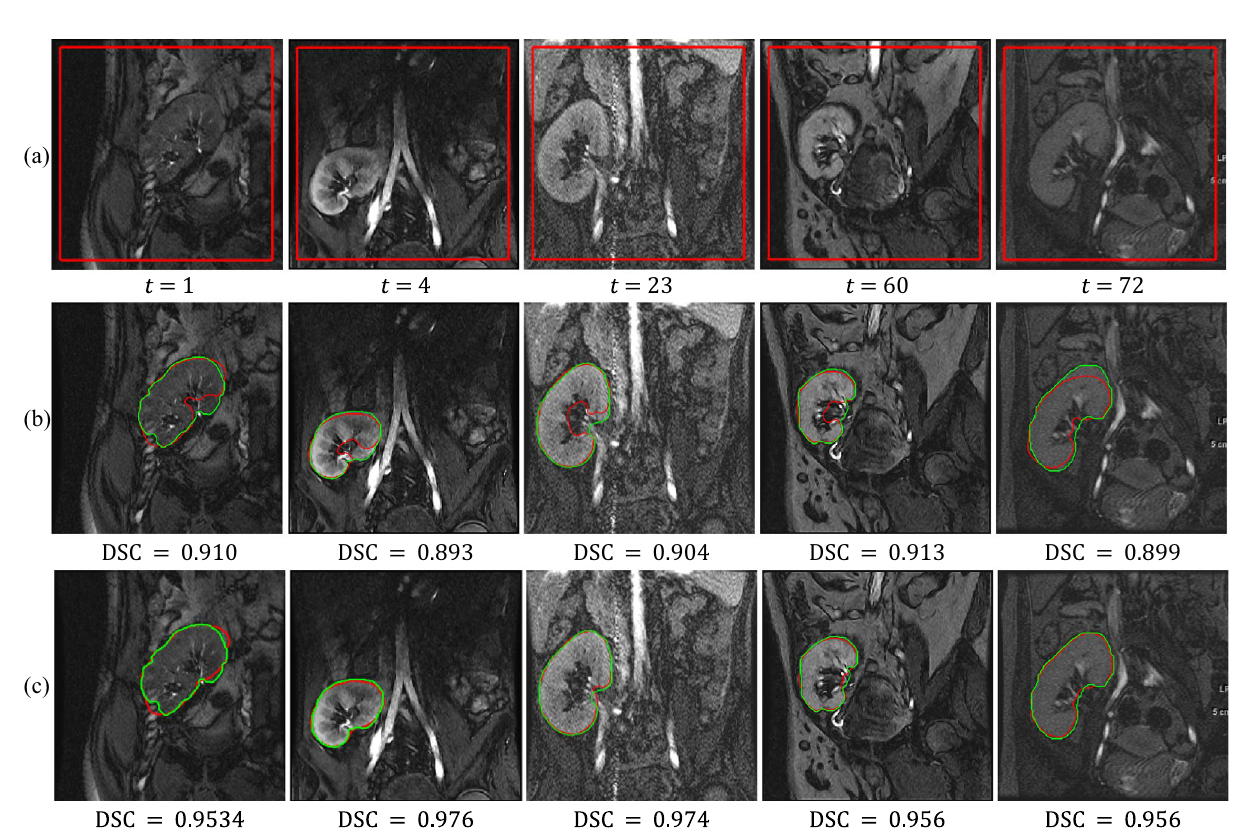
Figure 3. Segmentation results of FML vs. FCMLS. ( a ) DCE-MRI kidney images with initial LS contour. Segmentation results outlined in red with DSC values for the kidneys segmented by FCMLS in ( b ) and FML in ( c ). The ground-truth segmentations are superimposed on the images in green. Please refer to Supplementary Fig. S3 online for better visualization of segmentation